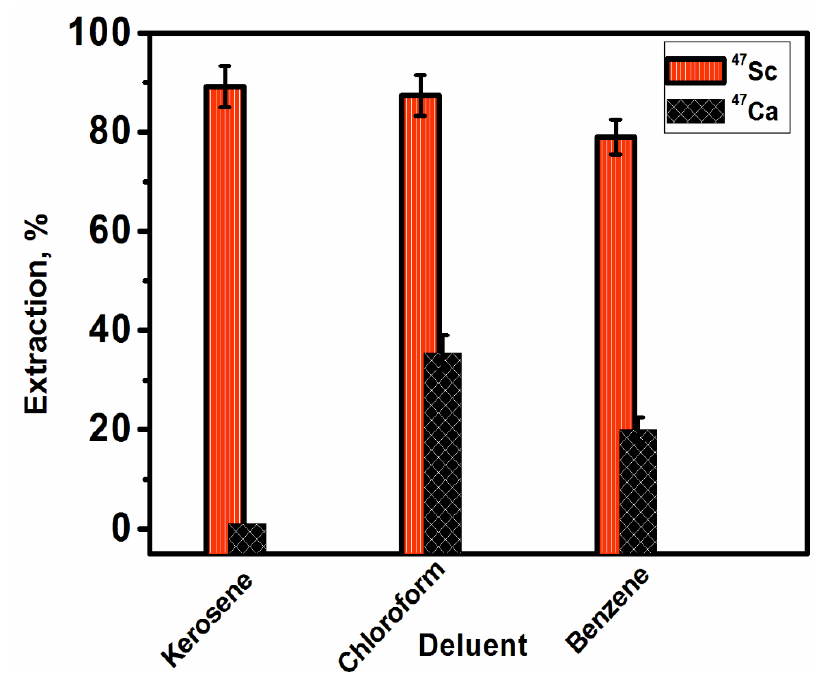
Figure 4. Effect of diluent type on the extraction of 47 Sc and 47 Ca: 1:1 phase ratio, 0.025 M Cyanex 272, 30 min extraction time, pH 1.8, and 25 ± 1 °C.